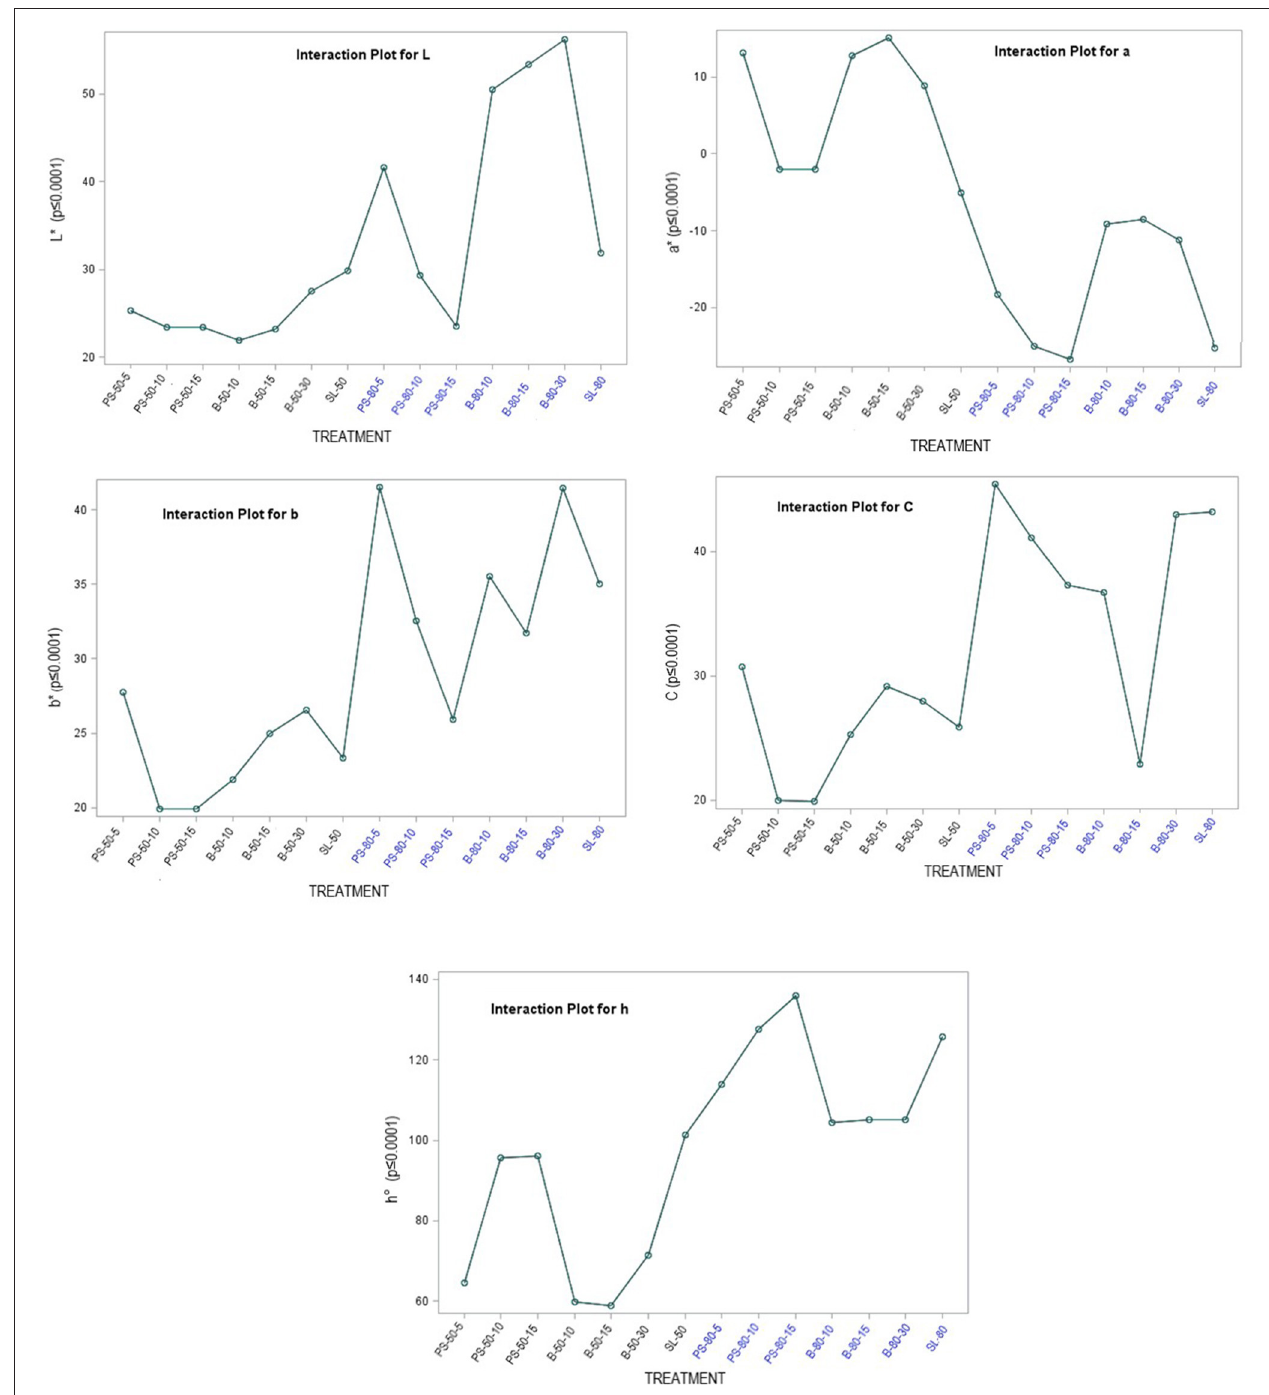
FIGURE 5 | Chromaticity parameters of nettle alcoholic extracts: L* value; a* value; b* value; C value; h ◦ value.